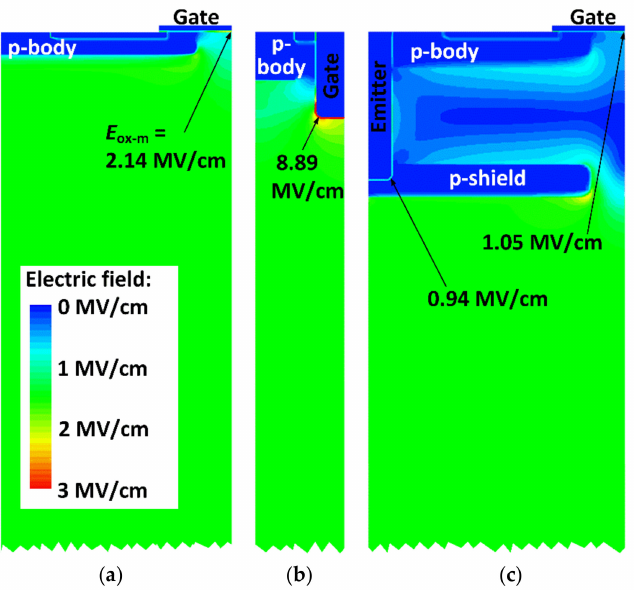
Figure 5. Off-state electric field distribution in the studied SiC IGBTs under V CE = 20 kV and